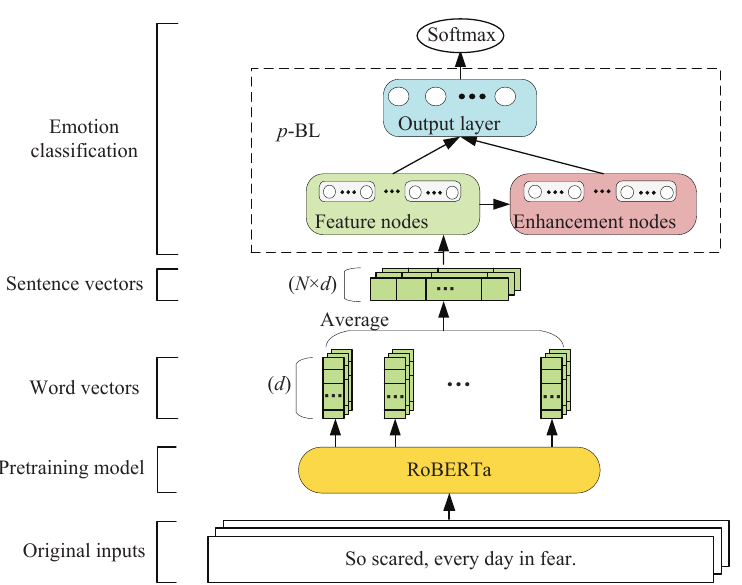
Fig. 1 The overall structure of negative emotion classification.